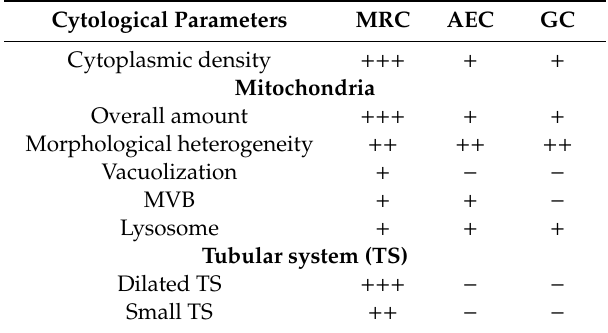
Figure 4. Transmission electron micrograph of MRC connected with the AEC in mucosal layer of P. sinensis . Mitochondria-rich cell (MRC), absorptive epithelial cell (AEC), tight junction (Tj), desmosome (D), interdigitation (ID), mitochondria (M), tubular system (T), multivesicular bodies (white arrow); vacuolization in mitochondria (white arrowhead), intermitochondrial junction (thick black arrow), lysosome (black arrowhead), microvilli (Mv). Scale bar = 1 µm. Table 1. Summary of the distribution of cytological features of MRC, AEC, and GC in the mucosal layer of small intestine of Chinese soft-shelled turtle (n = 3).